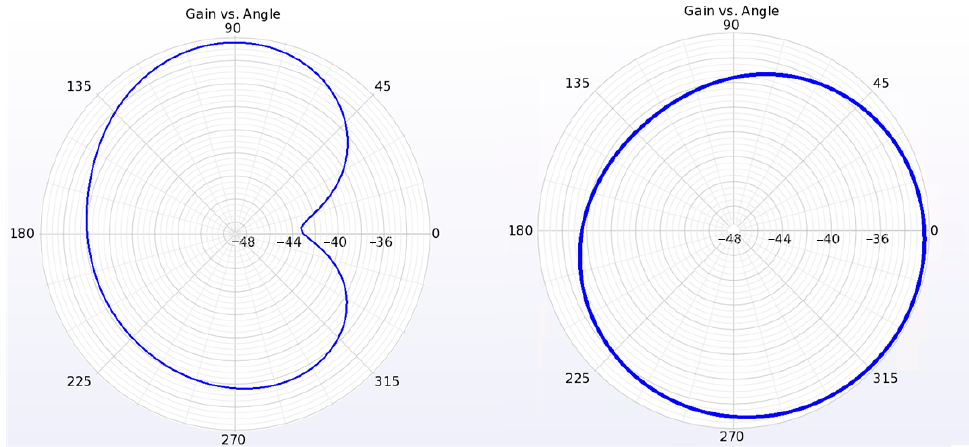
Figure 6. Antenna gain: left for YZ plane and right for X–Y plane (according to Figure 3).